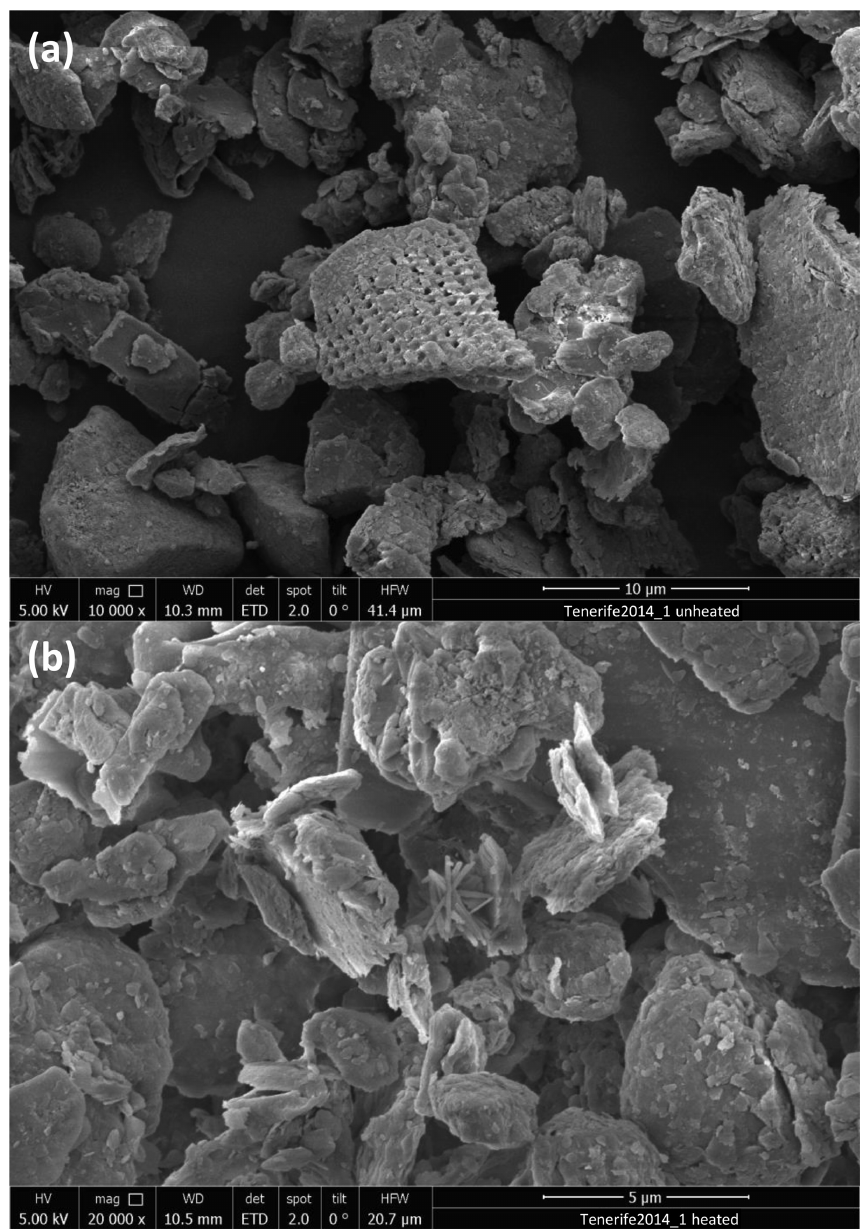
Figure 8. Scanning electron microscopy images of the (a) unheated and (b) heated Tenerife2014_1 sample. Note the different scales in the two